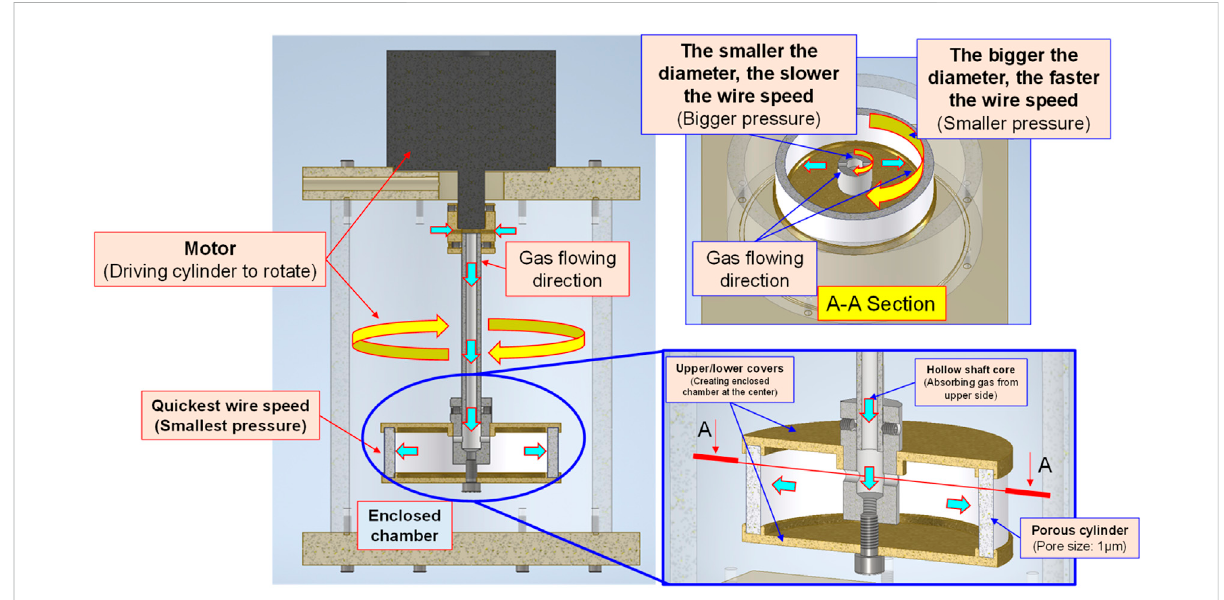
FIGURE 4 Schematic diagram and structural layout of bubble re fi ning device for porous disc rotary